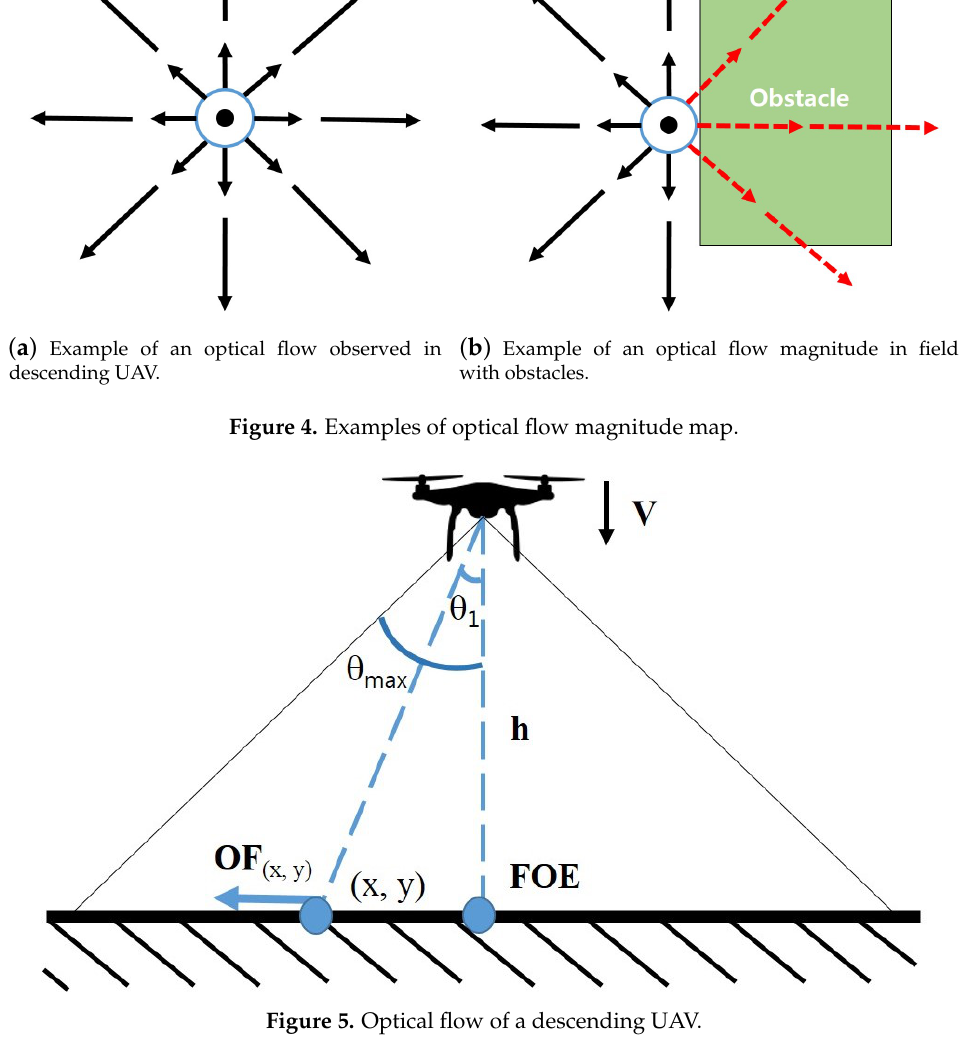
Figure 5. Optical flow of a descending